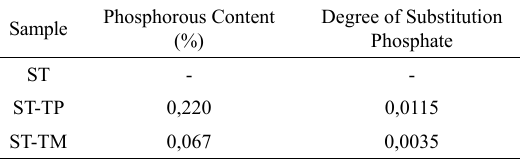
Table 2. Degree of substitution.